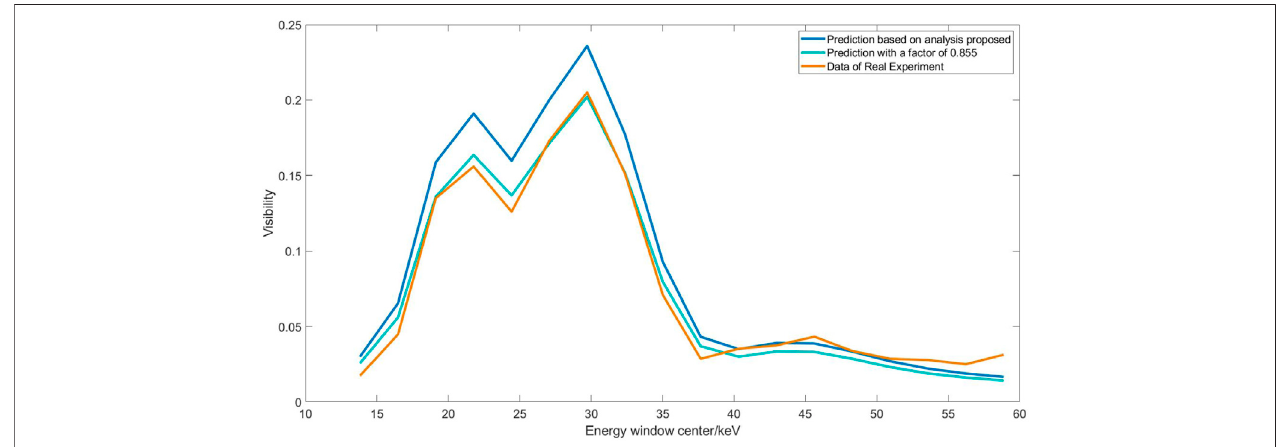
FIGURE 3 | Comparison of the analysis and real